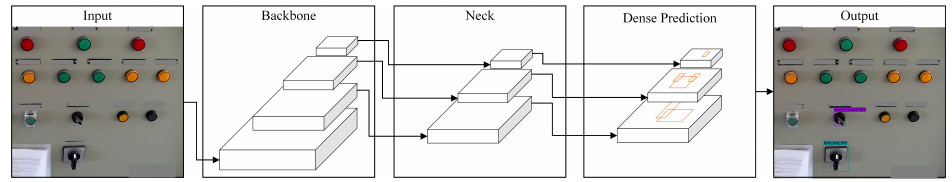
Figure 5. YOLOv4 knob area positioning